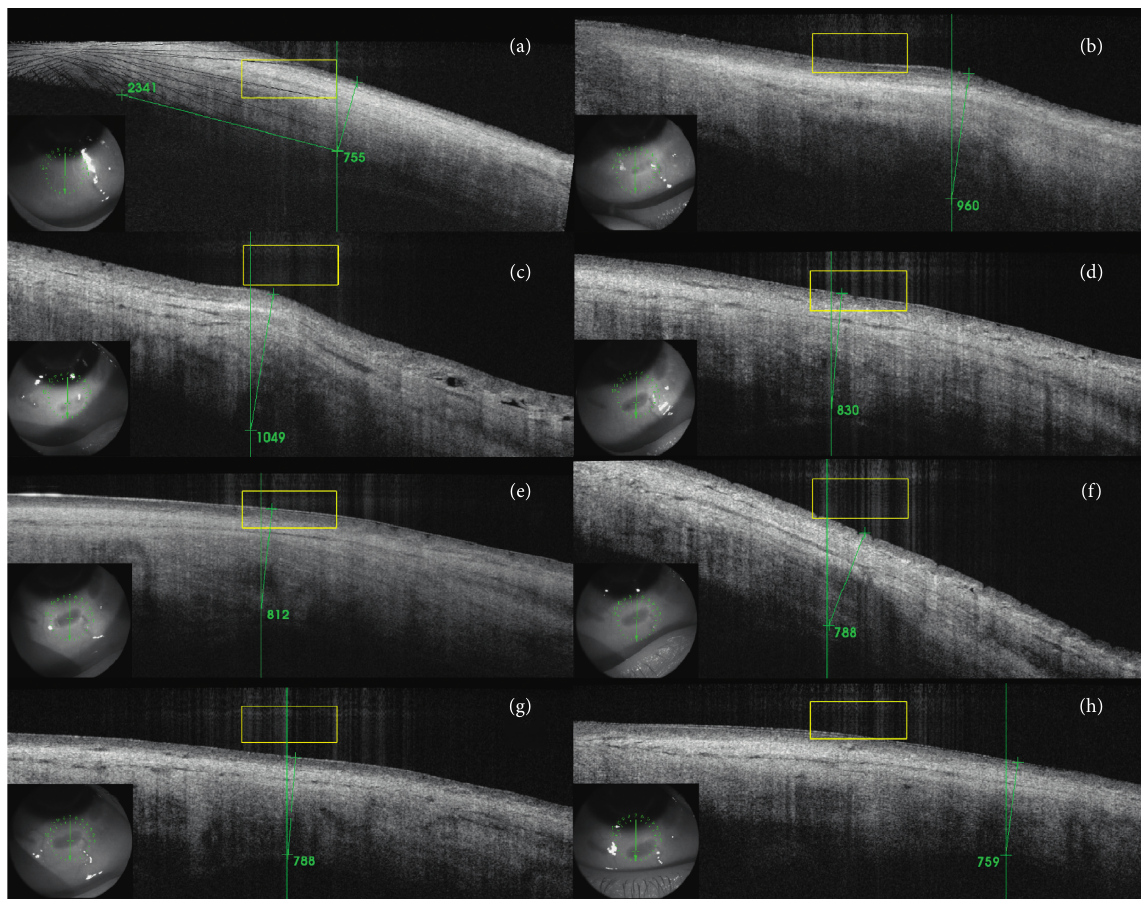
Figure 8: Inferior-quadrant OCTscans of the sclera and conjunctiva of a patient before the procedure (a), at 1 week (b), and 1 (c), 3 (d), 6 (e), 12 (f), 18 (g), and 24 (h) months after UCP—24-month follow-up